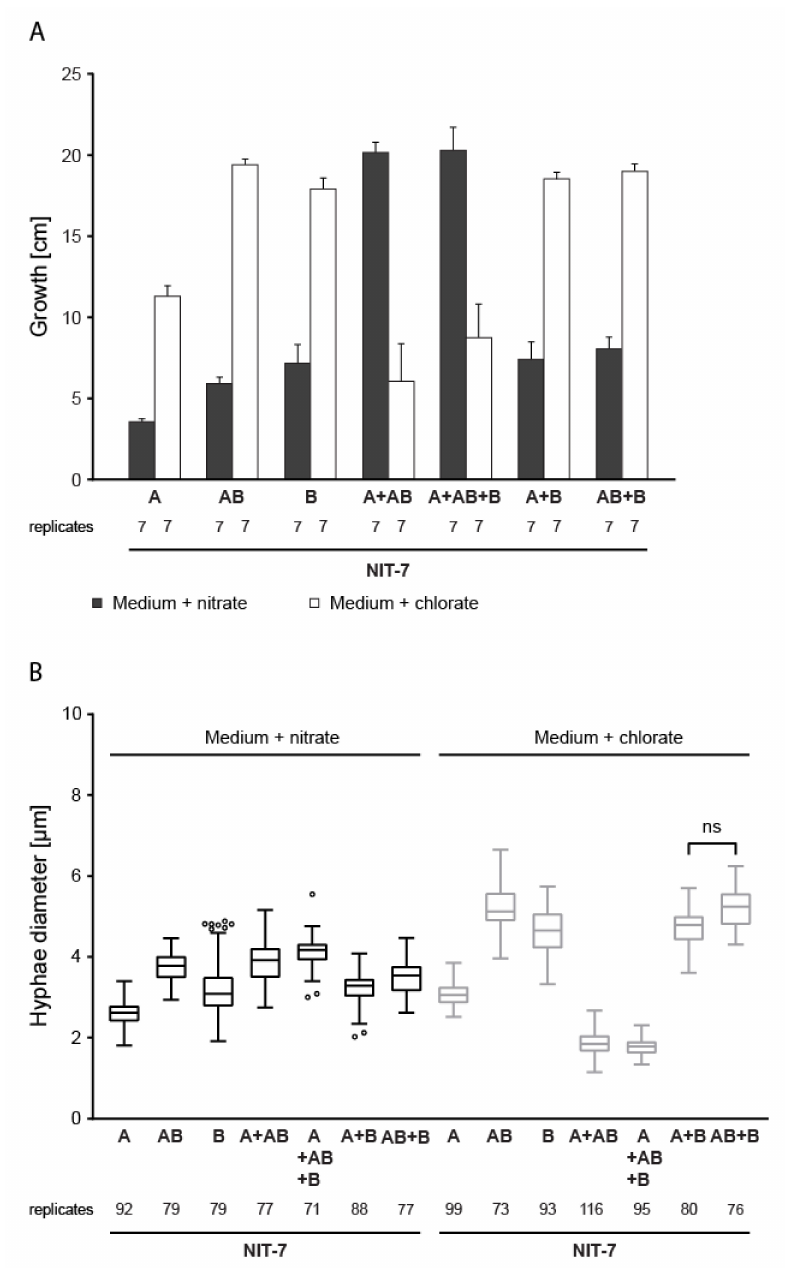
Figure 6. Functional complementation of the Neurospora crassa nit-7 mutant strain. ( A ) Neurospora crassa nit-7 knock out strains ectopically expressing either nit-7a , nit-7b , or nit-7ab (Table 1) were generated and grown as heterokaryons under nitrogen derepressing and nitrate-inducing conditions (nitrate-containing medium) and on chlorate-containing medium, respectively. ( B ) The hyphal diameter of the strains analyzed in ( A ) has been determined and is shown as Tukey´s box plots. Multiple comparisons analysis was carried out using ordinary one-way ANOVA (Tukey´s method). Di ff erences, which are not significant, are indicated